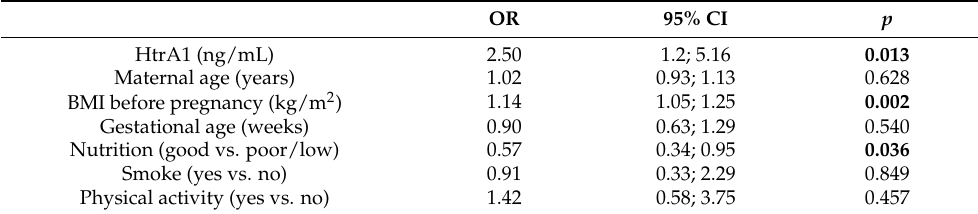
Table 3. Factors evaluated at the first trimester of gestation associated with GDM. Results of logistic regression